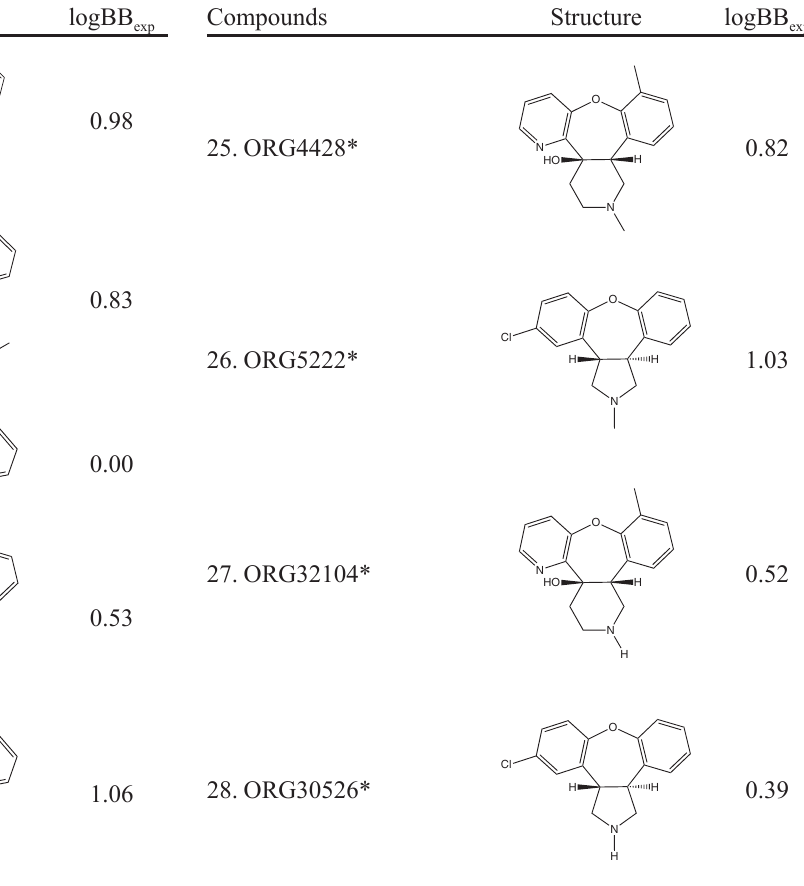
TABLE I - Chemical structures and logBB experimental values (logBBexp) found for training and test sets (Katritzky et al. , 2006). The test set compounds are marked with an asterisk (*) (cont.)